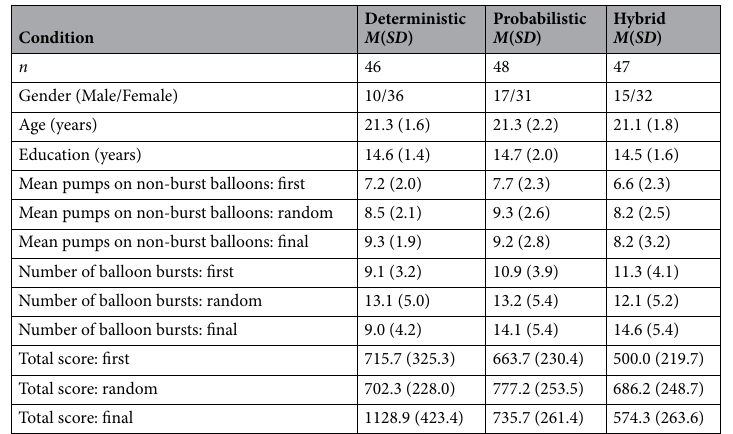
Table 1. Descriptive data of demographic variables and BART performance in the three conditions. Each task phase consisted of 30 balloons. First and final phases had the same structure within conditions, but these phases differed across conditions (see main text for details). In the random (middle) phase, random balloon tolerance values were used, without the increasing burst probabilities within each balloon. The conditions did not differ in gender ( p = 0.324), age ( p = 0.852), and education ( p =